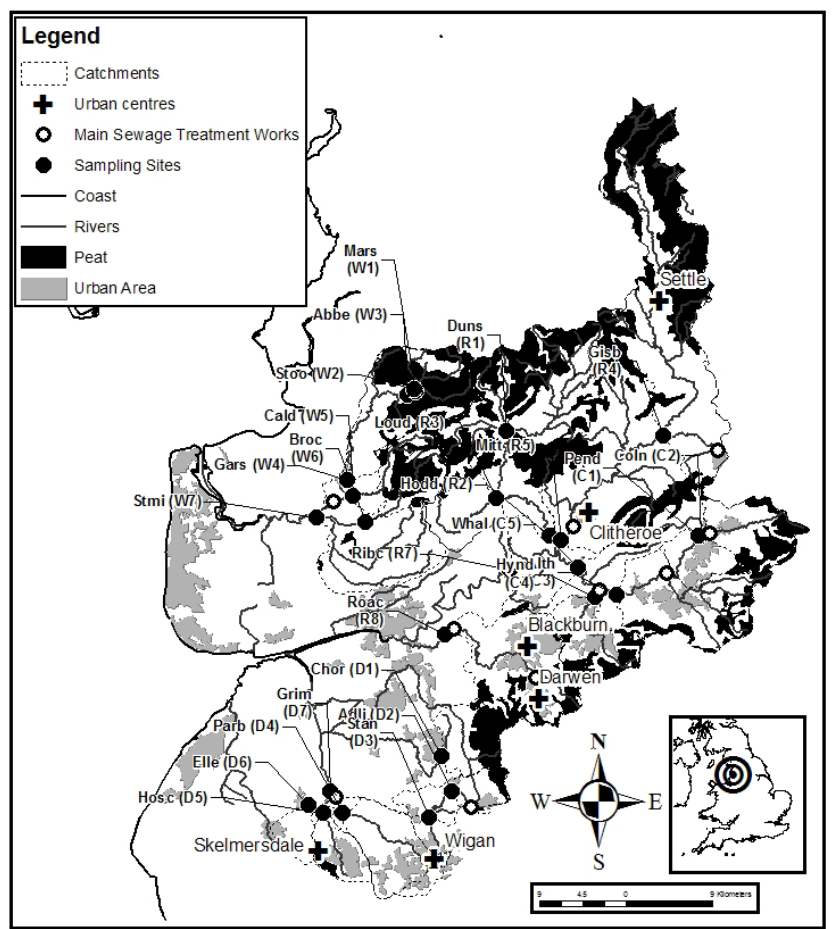
Figure 1. Location map of Calder, Douglas, Ribble and Wyre river basins and respective sampling sites.